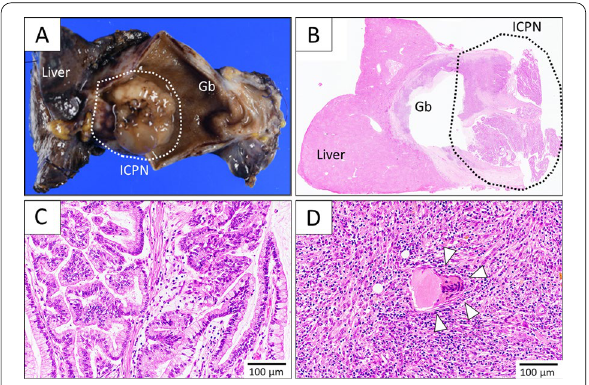
Fig. 2 Pathological findings. A Gross inspection of the resected specimens revealed that the mass had extroversive development from the mucosa of the gallbladder and contained some mucinous cysts. The mucus adhered to the surface of tumors. B–D Hematoxylin and eosin-stained histological sections. B Magnification 40. C × Magnification 200. D Magnification 200. The papillary growth × × was composed of atypical cells along with the development of fibrovascular stalks. Some of these tall columnar cells contained rich mucus. There was no evidence of tumor invasion. The gallbladder wall was highly thickened by the presence of severe inflammatory lesions containing lymphocytes and multinucleated giant cells, which were considered to indicate chronic granulomatous changes in the wall. The histological diagnosis was intracystic papillary